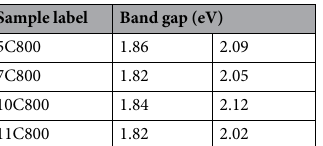
Table 4. Band gap of the samples synthesized at 800 °C.